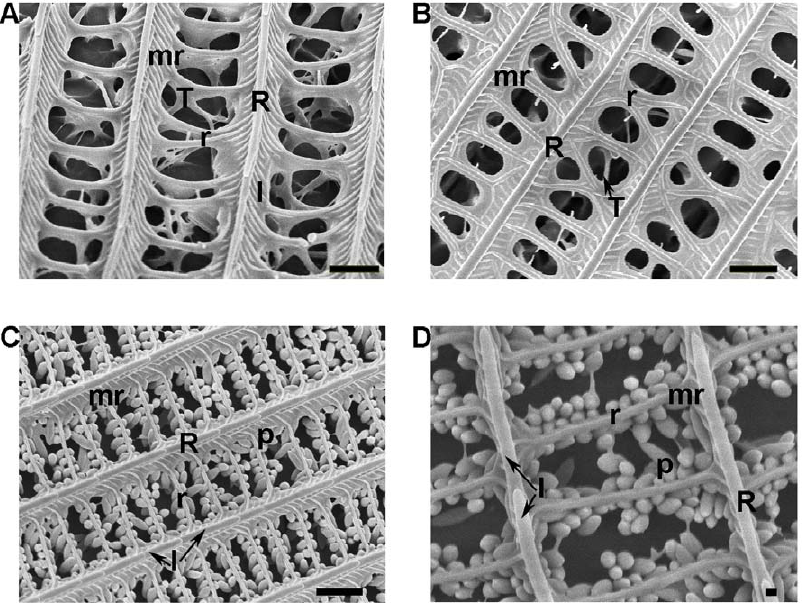
Figure 2. SEM images of a scale fragment. Showing the complicated upper lamina and the interior of a scale. Ridges (R), lamellae (l), microribs (mr) and crossribs (r) are indicated distinctly. ( A and B ) Multiform trabeculae (T) connect with each other and form various mesh between the upper and bottom laminae within the scale of Spilosoma niveus ( A ) and Rhyparioides amurensis ( B ). Scale bar, 1 m m. ( C and D ) These meshworks all run into one another within the scale. Ridges and microribs form many close and regular windows, and pigment granules (p) could be seen in Pieris canidia ( C ) and Colias erate ( D ) scales, although trabeculae were not apparent. Scale bars, 1 m m ( C ), 100 nm ( D ).